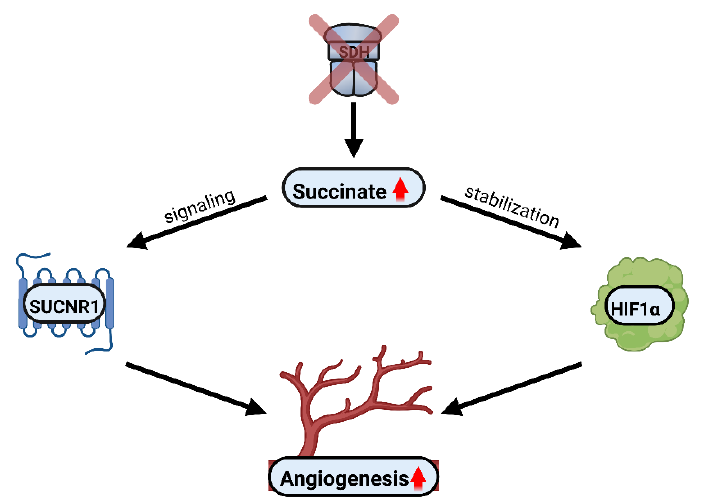
Figure 6. SDH, HIF1 α and SUCNR1 are key targets modulating angiogenesis. In conditions where the expression and/or the activity of SDH are hindered, succinate levels increase. Accumulation of succinate can induce angiogenesis via two mechanisms, either through HIF1 α stabilization or by SUCNR1 signaling. This has been shown in many pathological settings so far and is yet to be exploited to ameliorate pathological angiogenesis. Red arrows stand for elevated succinate concentrations and increased angiogenesis.